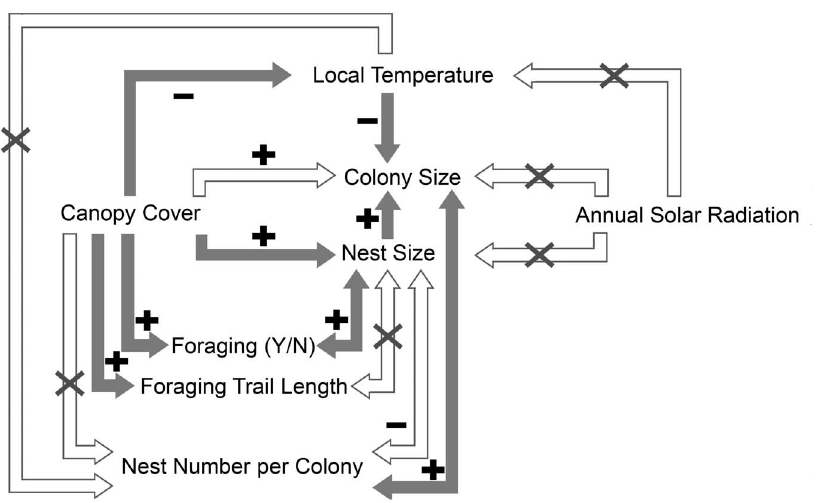
Fig. 7. The relationships of colony size and nest size to possible related factors in our study. Arrows illustrate the possible direction of causality. Solid arrow, hollow arrow and hollow arrow with a cross indicate the significant, the borderline significant and the non-significant relationships respectively. Plus and minus signs indicate the relationships as positive and negative respectively.